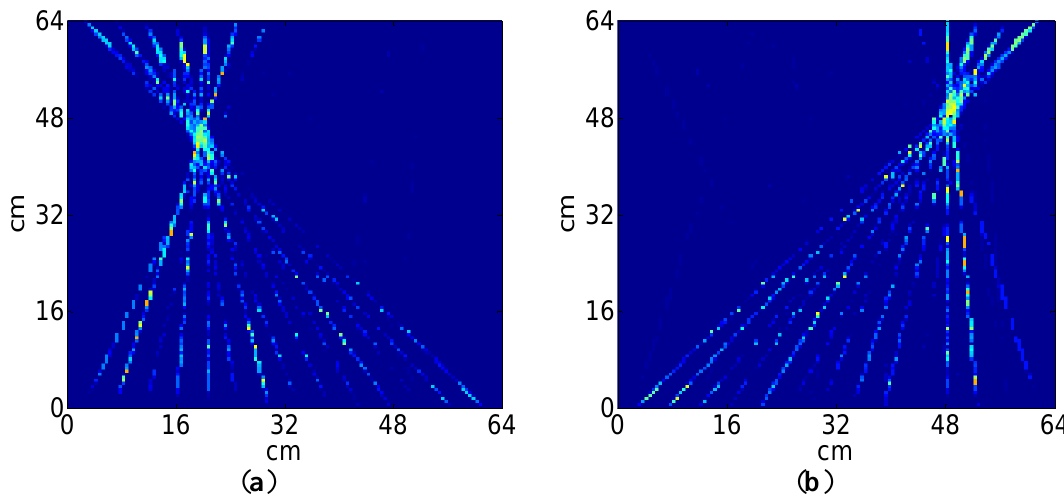
Figure 13. Experimental ULW TI results with the defect in locations ( a ) (20 cm, 44 cm) and ( b ) (49 cm, 49